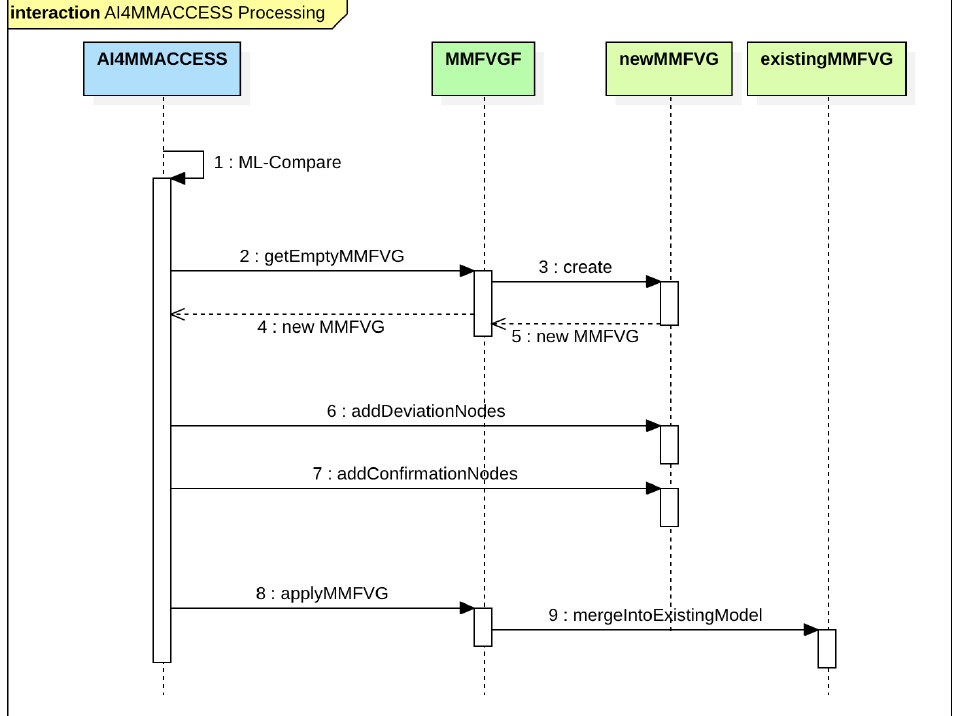
Figure 14. Processing of deviations and confirmations within the